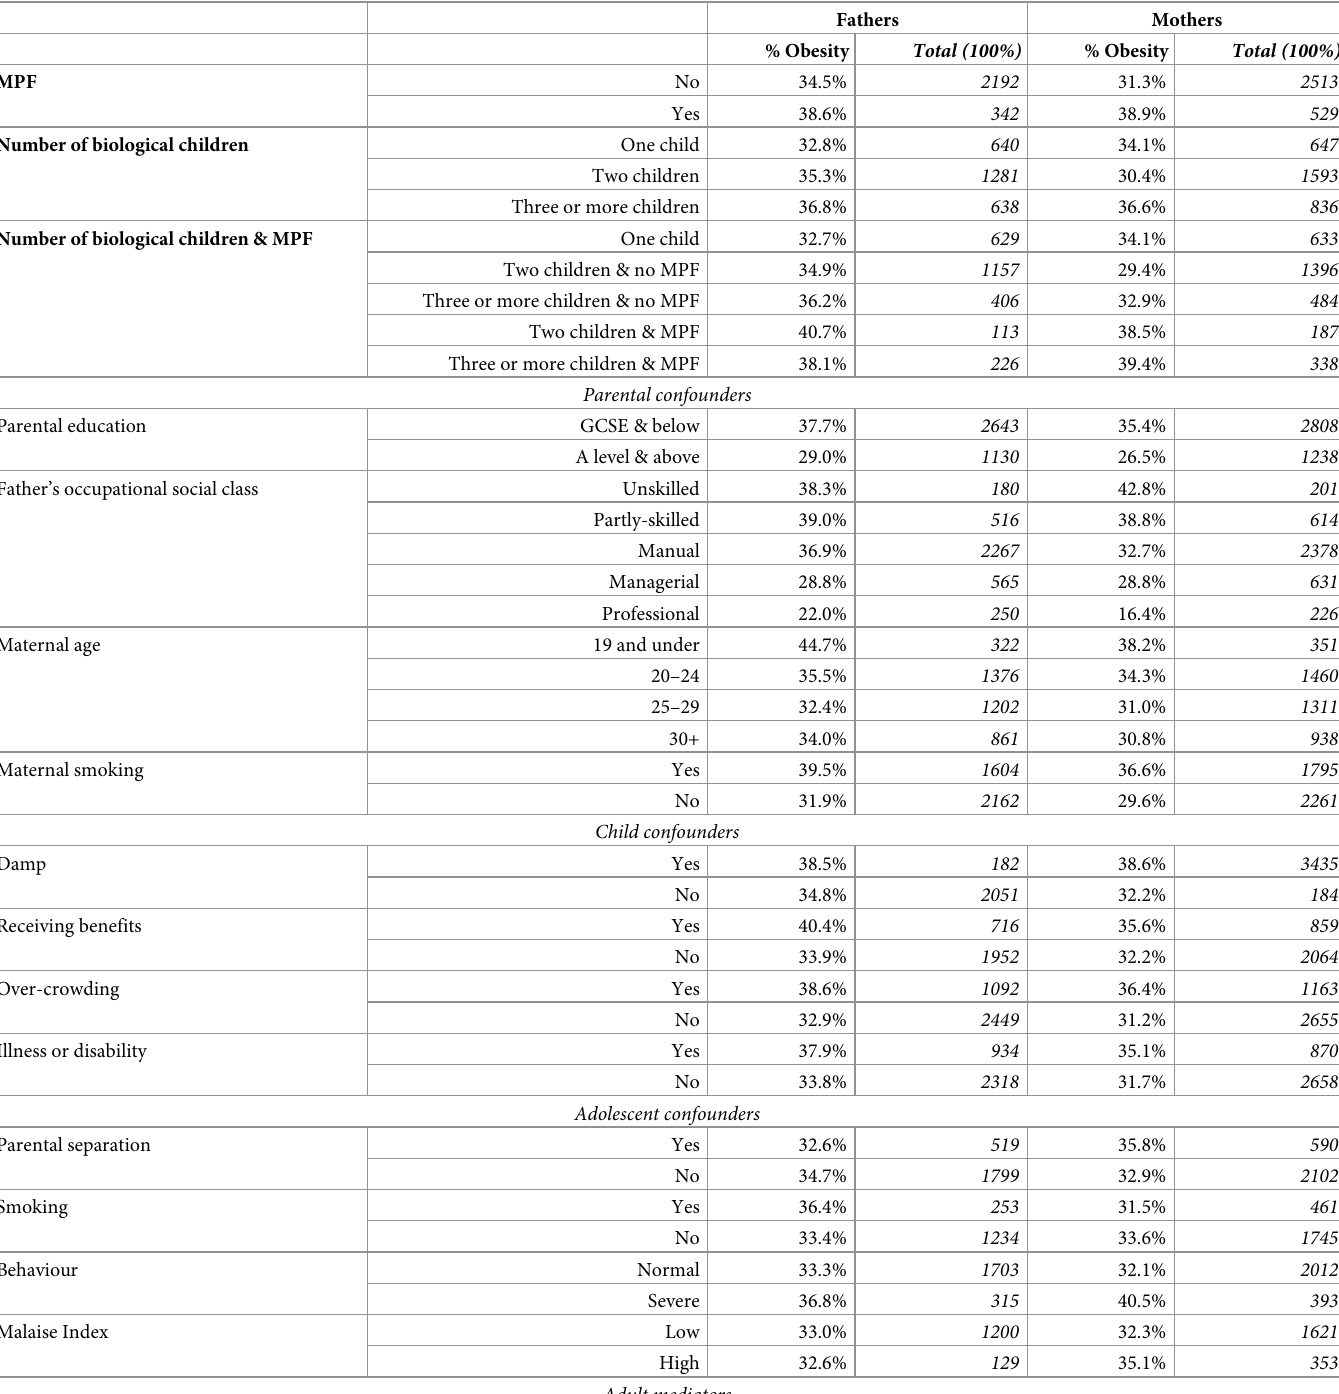
Table 1. Sample characteristics by obesity status at age 46. Fathers and mothers born in